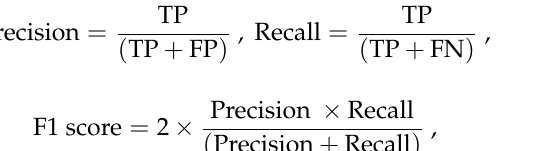
Figure 8. Optimization and deploy